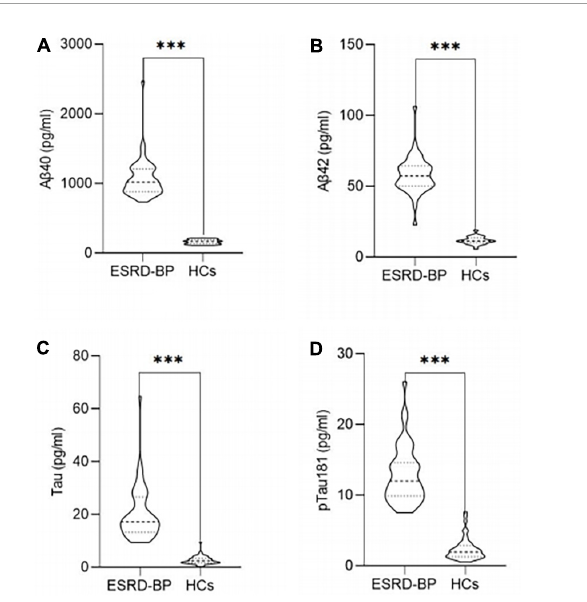
FIGURE3 Comparison of the plasma concentrations of A β 40 (A) , A β 42 (B) , Tau (C) , and pTau181 (D) between ESRD-BP ( n = 44) and HCs ( n = 46) ( ∗∗∗ P < 0.05). ESRD-BP, end-stage renal disease patients undergoing blood purification; HCs, healthy